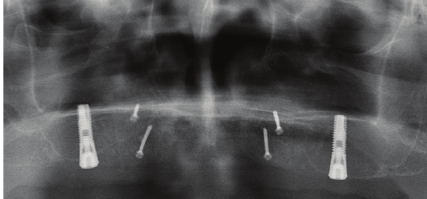
Figure 1: One-week postoperative baseline panoramic view over reconstructed atrophic maxilla. Block bone grafts attached with titanium screws in the anterior and sinus membrane elevation performed in the maxillary sinus floor. Notice the minute amount of bone (1-2mm) in the sinus floor. The conical shape of the marginal part of the implant represents 5mm.